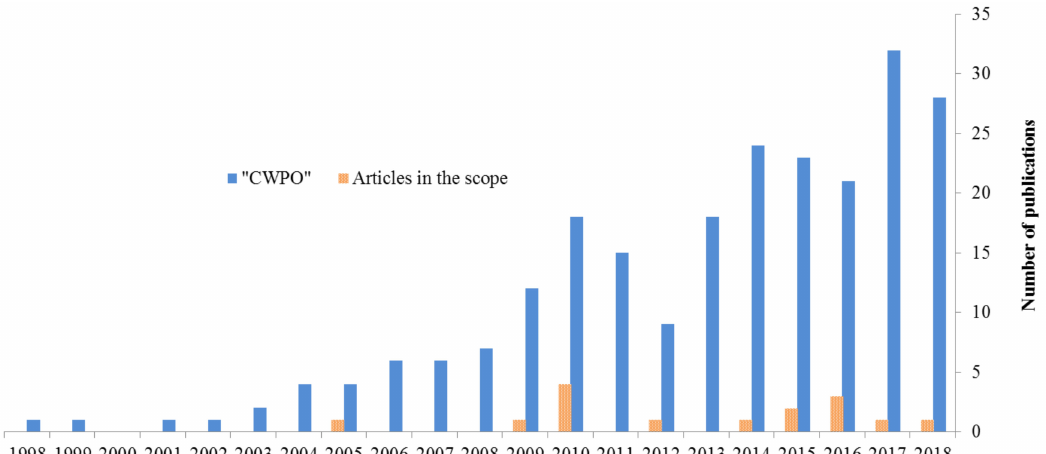
Figure 1. Number of scientific publications (Scopus) containing keywords: "CWPO" in the title and/or abstract and/or keywords of article (blue). Number of articles in the scope of the review (real wastewater matrix was used) in